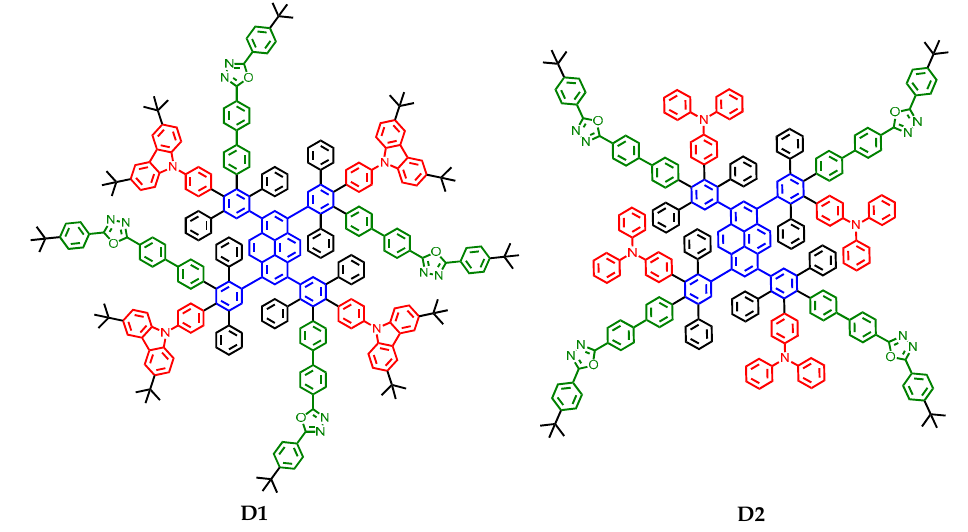
Figure 1. Molecular structures of donor-acceptor dendrimers D1 and D2 .